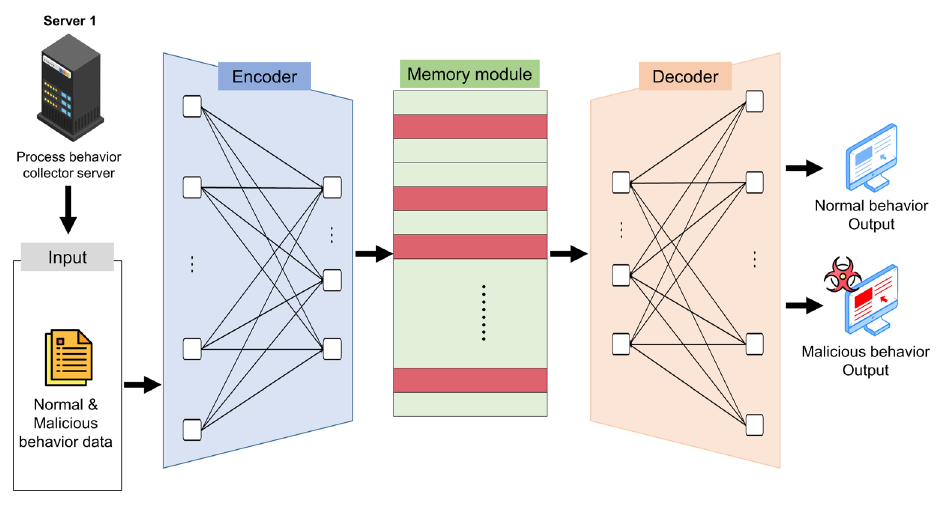
Figure 5. Malicious process behavior detection model.